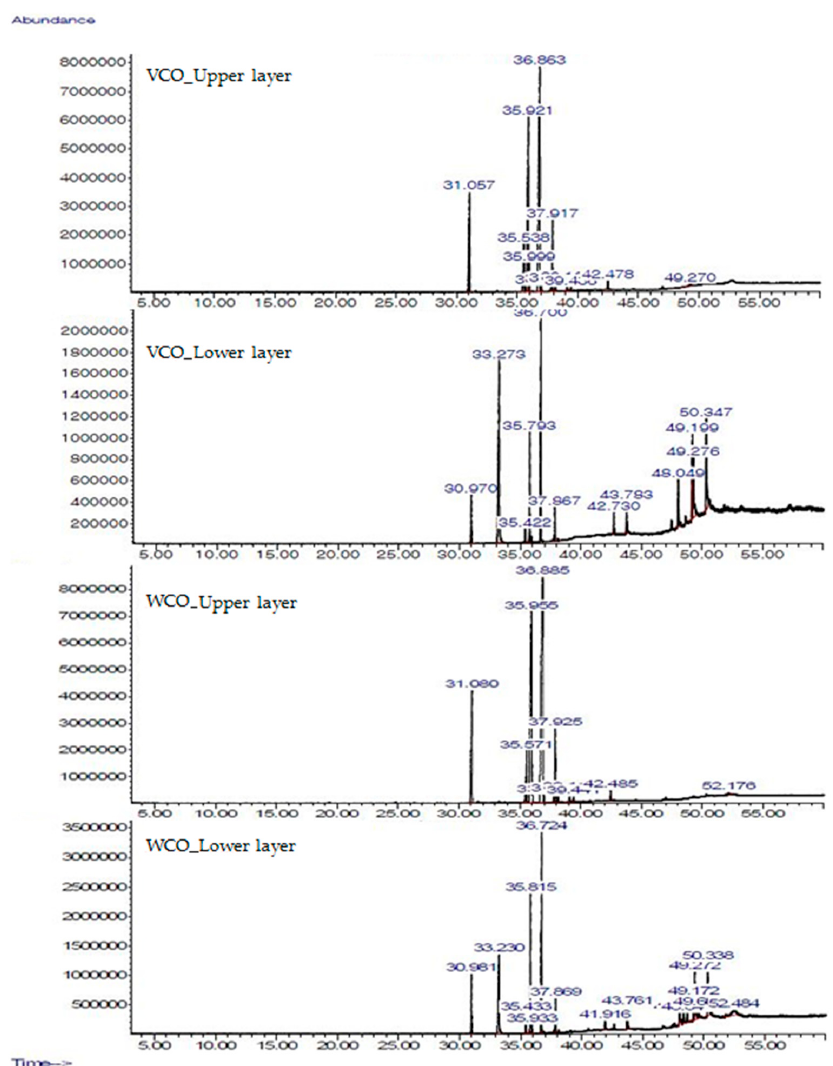
Figure 4. The upper and lower layer obtained from supercritical transesterification ( a ) VCO + methanol ( b ) WCO + methanol ( c ) VCO + ethanol, and ( d ) WCO + ethanol. Energies 2017 , 10 , 546